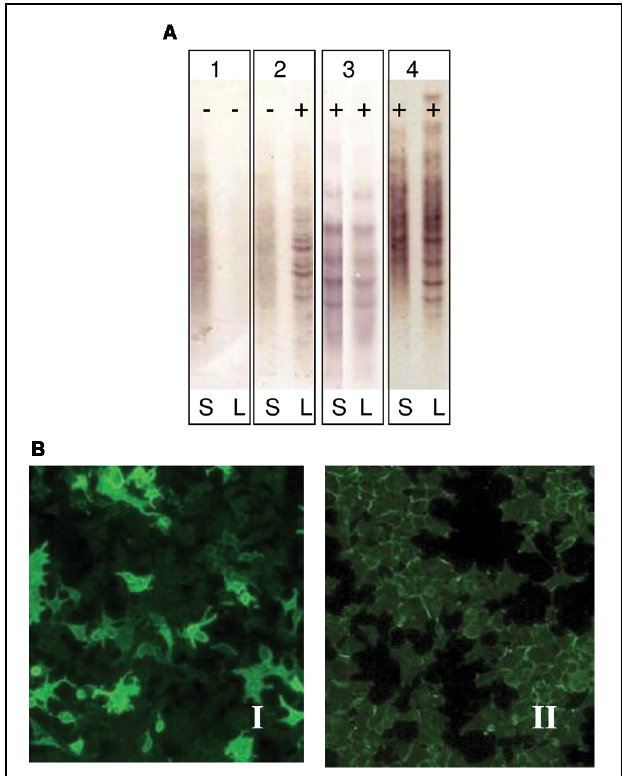
FIGURE 1 | (A) Immunodetection of oligoclonal bands (OCBs) in serum (S) and cerebrospinal fluid (CSF) (L). Pattern 1: No OCBs seen (negative, polyclonal): No OCBs in CSF or serum. No intrathecal Ig synthesis; Pattern 2: OCBs in CSF only (positive): OCBs present in CSF only. Intrathecal IgG synthesis as seen in MS; Pattern 3: Identical OCBs in both (mirror images): Bands in serum mirror those in CSF. This suggests systemic Ig synthesis; Pattern 4: Identical OCBs in both with extra bands in CSF: Identical bands in both serum and CSF with extra bands in CSF. Image demonstrates both